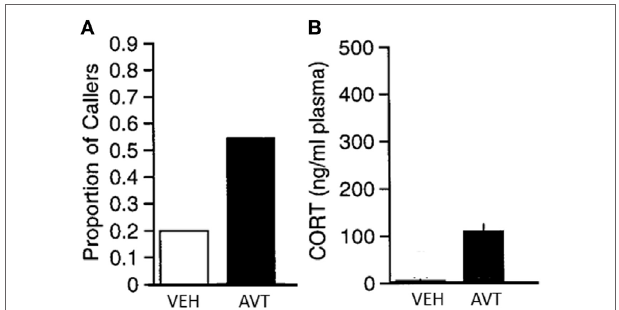
FiGURe 5 | (A) Significant increase in the proportion of male green treefrogs that resumed spontaneous calling following and IP injection of 20 μ g arginine vasotocin (AVT) compared to vehicle (saline) injection. (B) Significant increase in plasma corticosterone (mean + SEM) following injection with 20 μ g AVT compared to vehicle (saline) injection. Results show that AVT increases calling even when stimulating corticosteroid release. N = 10 males per group. From data in Burmeister et al.